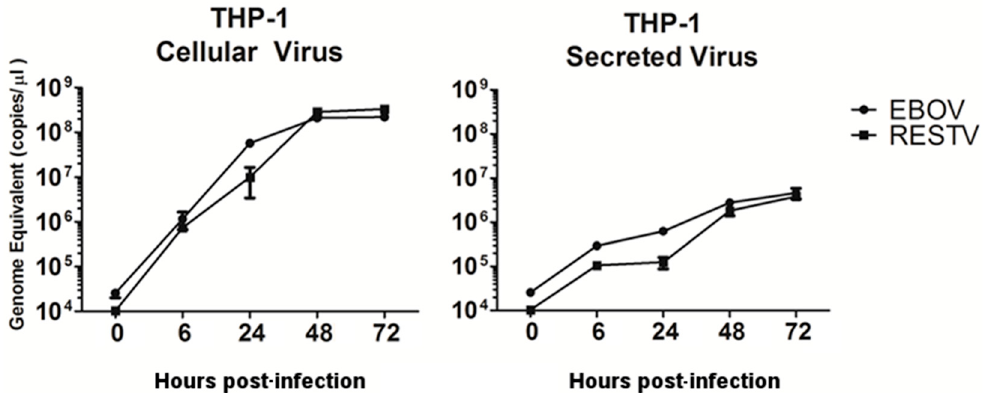
Figure 1. Genome abundance of Ebola virus (EBOV) and Reston virus (RESTV) in THP-1 cells at 0 to 72 h post-infection (hpi) measured in the supernatant, or from 6 to 72 hpi measured in cells using qRT-PCR. The assay was directed to detect mRNA corresponding to the GP gene of either EBOV or RESTV and quantified using the standard curve method with an artificially synthesised RNA transcript control. Data shown are in the log10 scale. Data based on two biological replicates for each condition and PCR performed with three technical replicates per condition for accurate measurement of viral RNA.